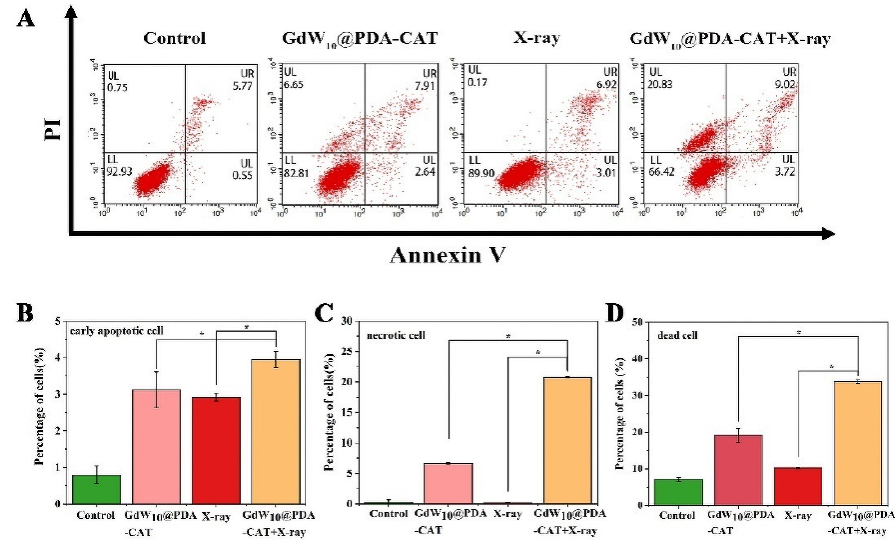
Figure 4. Apoptosis and necrosis of cells under different treatments. ( A ) Flow cytometric analysis of HT29 cell death under different treatments. Statistical analysis of early apoptotic cells ( B ), necrotic cells ( C ), and dead cells ( D ) under different treatments. The p Values were calculated by the Student’s t test: * p < 0.01.